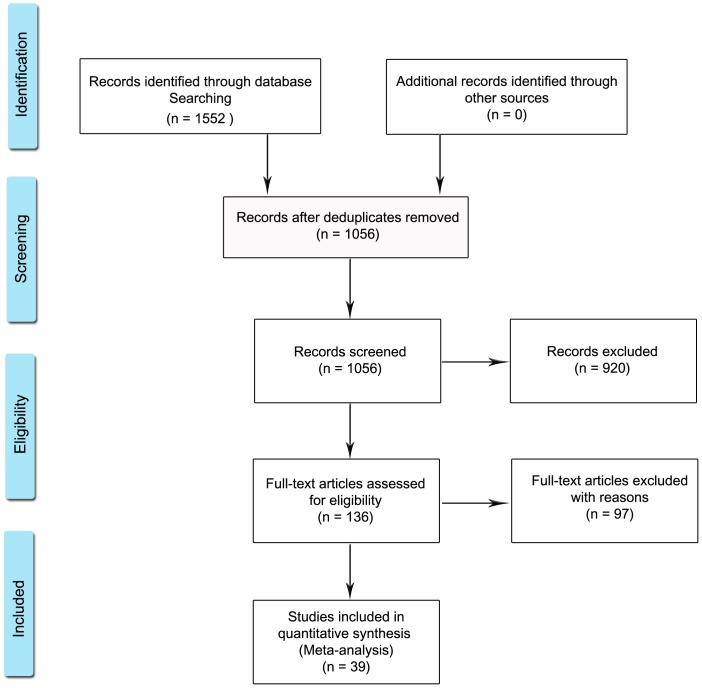
Studies identification in search strategy.Adopted from PRISMA 2009 Flow Diagram[16] (Moher, et al., 2009)*.